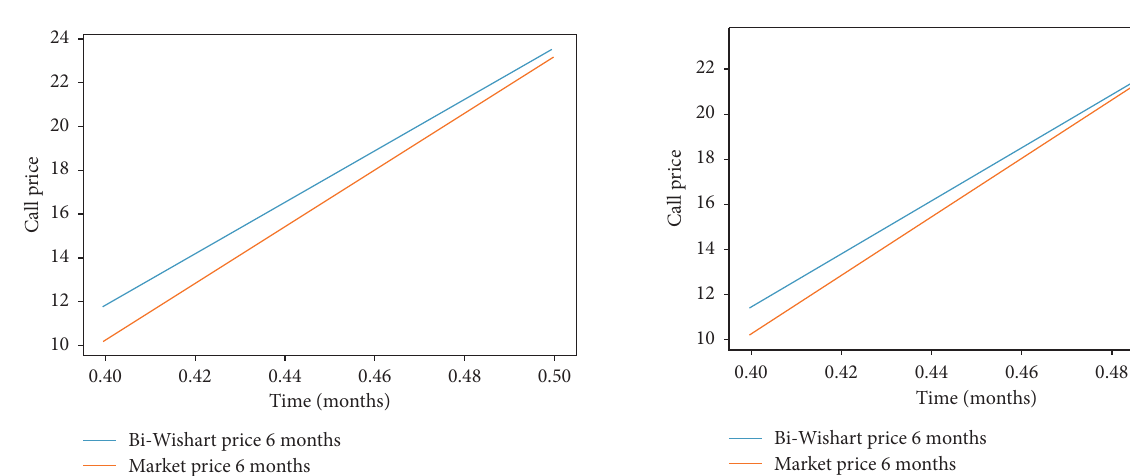
Figure 1: The price predictions at 6 months maturity time and the effect of model parameters on the call option price.